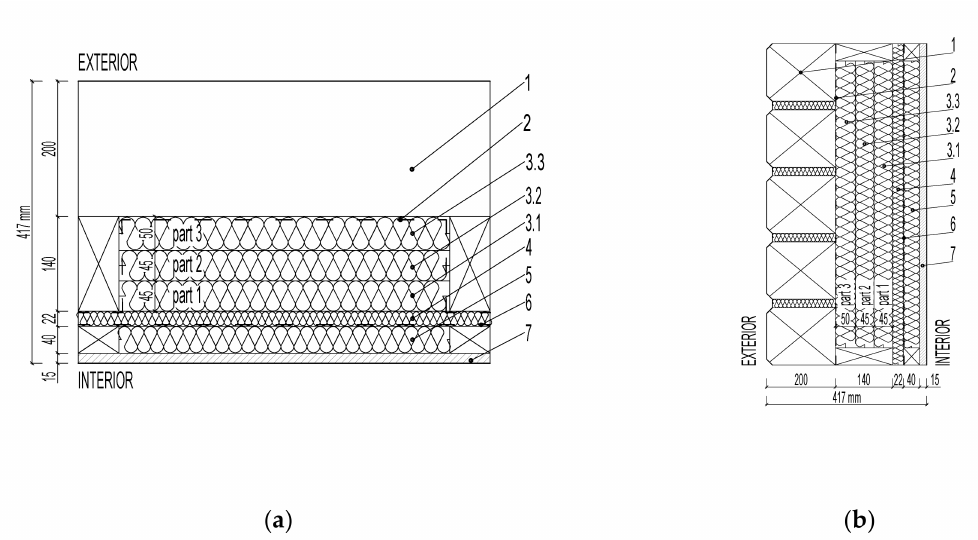
Figure 1. Log Wall LW1 with Vapor Barrier: ( a ) floor plan; ( b ) section. (1) Log Lumber; (2) House wrap ISOCELL OMEGA 180; (3.1) Fiberboard Insulation STEICO Flex, part 1; (3.2) Fiberboard Insulation STEICO Flex, part 2; (3.3) Fiberboard Insulation STEICO Flex, part 3; (4) Fiberboard Insulation STEICO Universal; (5) Fiberboard Insulation STEICO Flex; (6) Vapor Barrier ISOCELL.